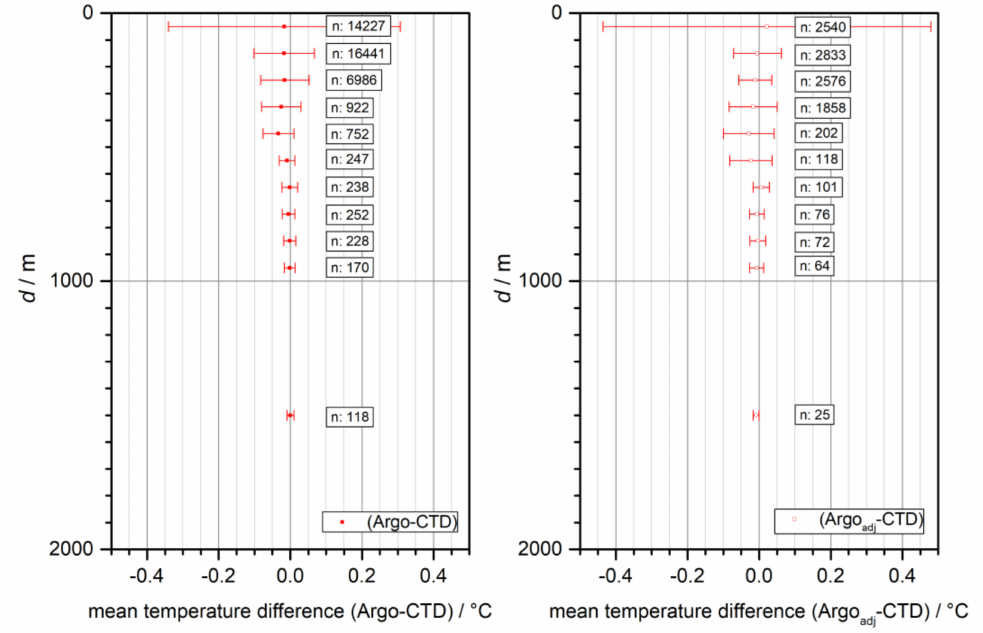
Figure 16. Mean temperature di ff erences and SD at depth intervals: Argo (not-adjusted, left , and adjusted, right ) vs. CTD.